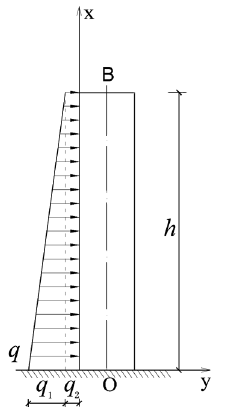
Fig. 10. Mechanical model of cantilever pile with trapezoidal distribution